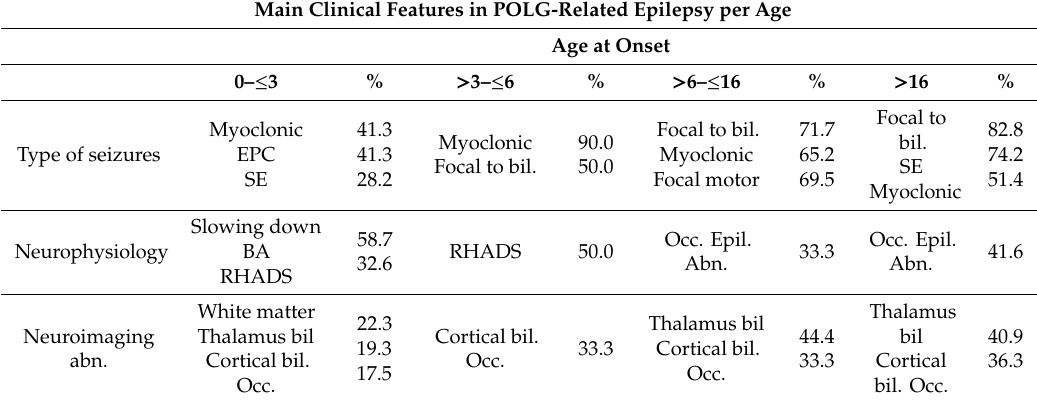
Table 4. Main clinical features in POLG-related epilepsy per age.